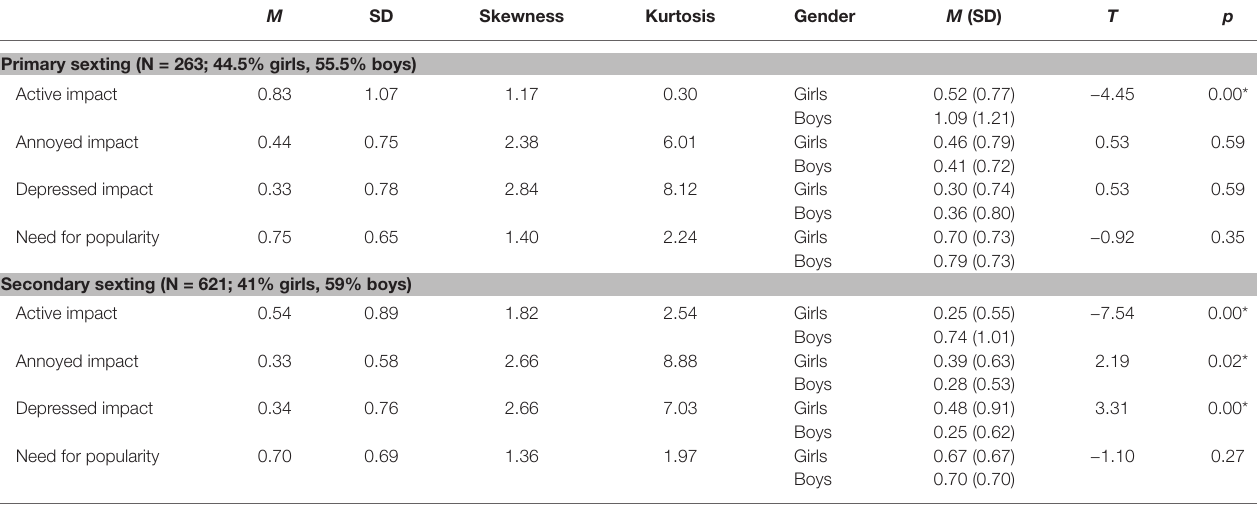
TABLE 1 | Descriptive statistics. M SD Skewness Kurtosis Gender M (SD) Primary sexting (N = 263; 44.5% girls, 55.5% boys)